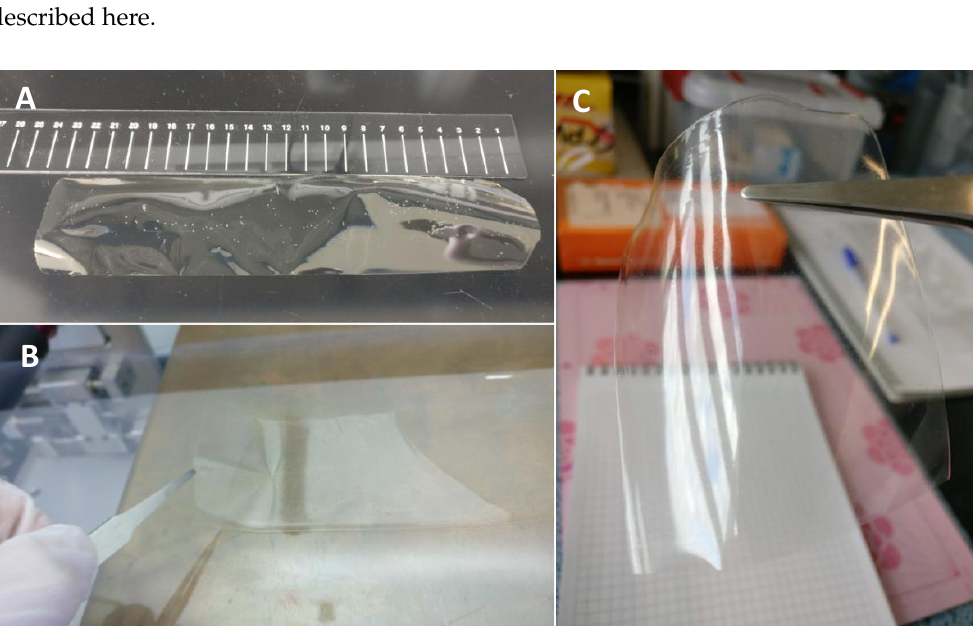
Figure 6. Photographs of the dry Chi-TEOS films approximately 23-24 cm in length (( A ), top left), being peeled off the PET substrate on the slot-die apparatus (( B ), bottom left) and a focus of a fragment demonstrating the transparency of the films (( C ), right).